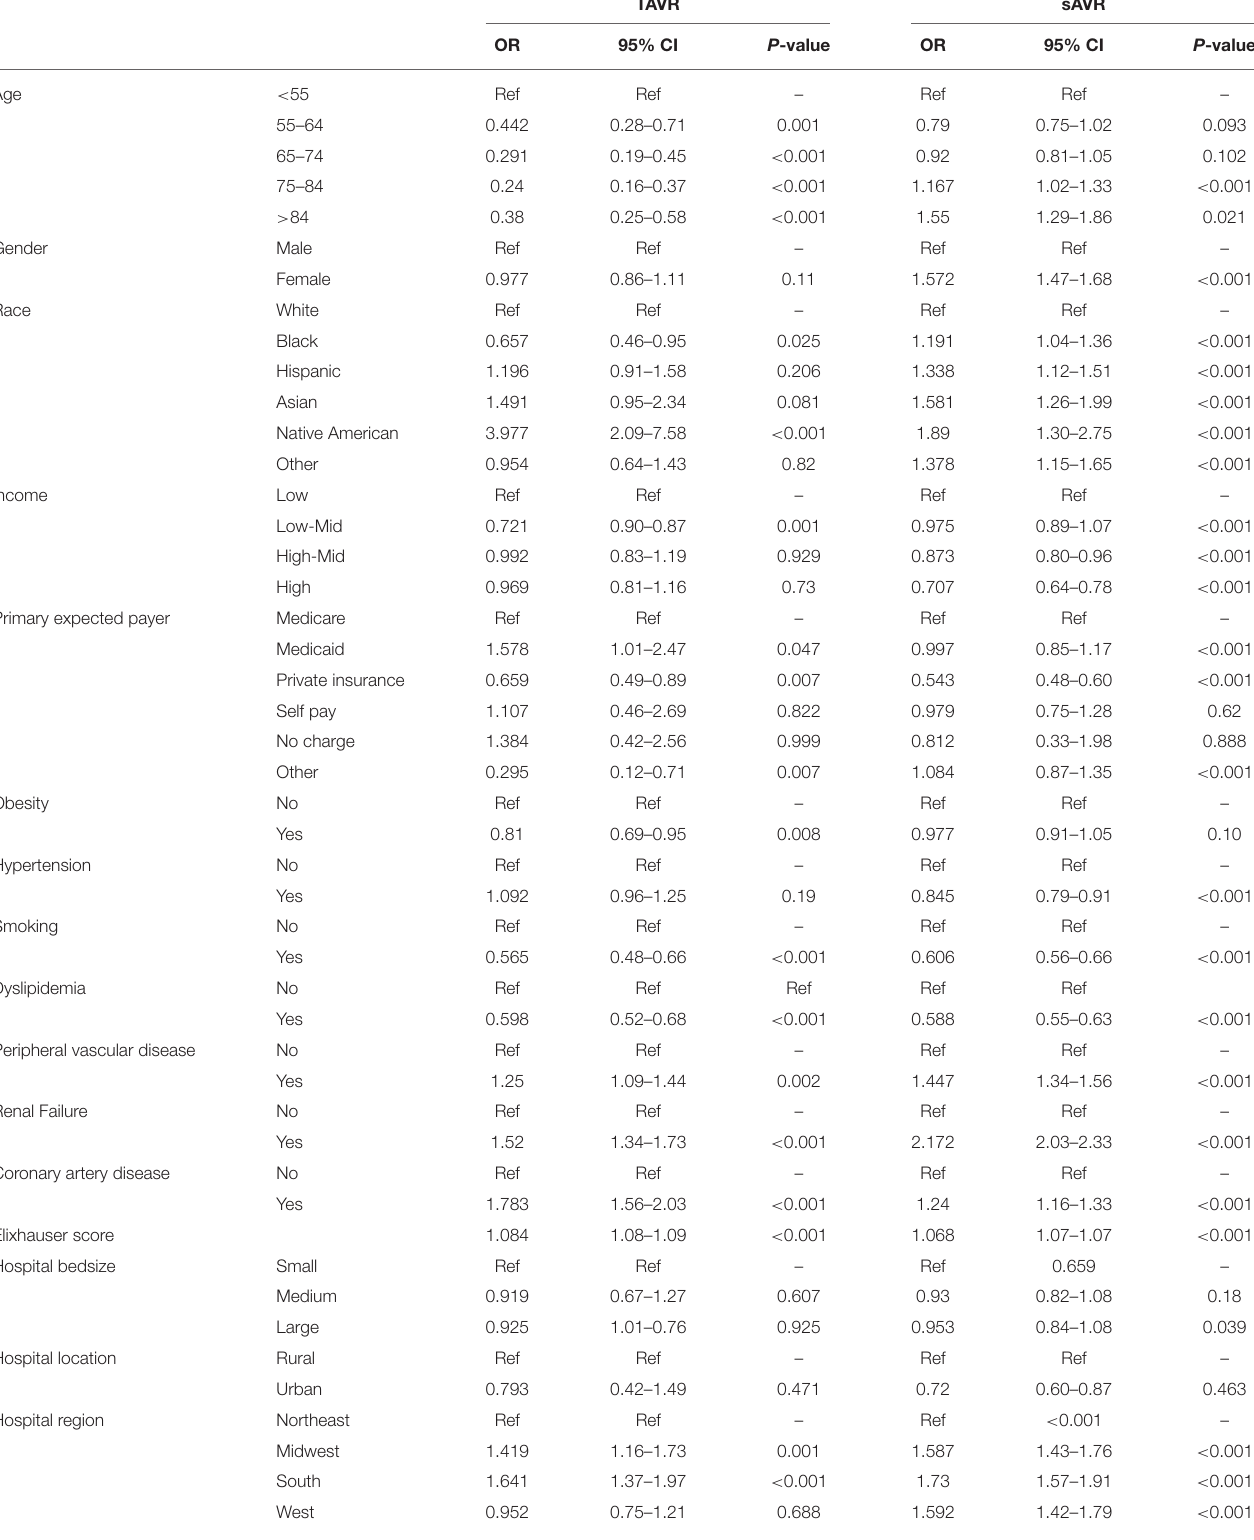
TABLE 6 | Predictors of mortality in patients with diabetes undergoing SAVR and